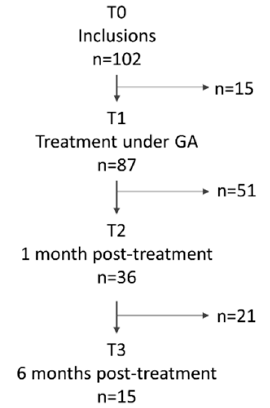
Figure 1. Flow chart of participation.